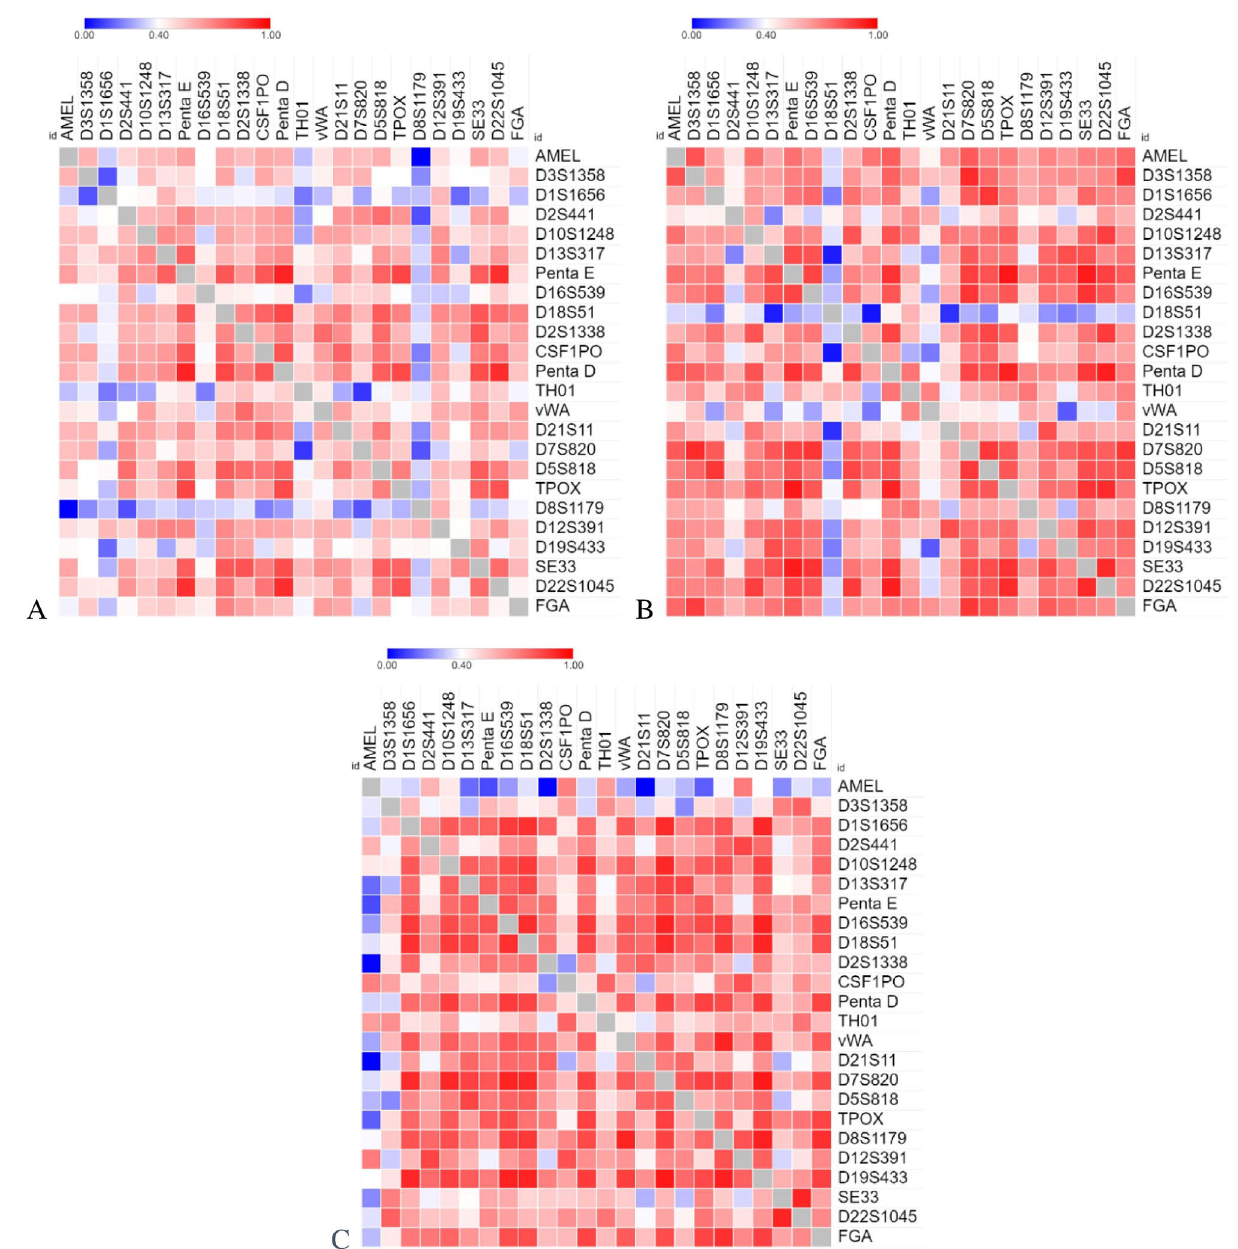
Figure 5. Spearman correlation of total allelic product at 29 cycles ( a ), 30 cycles ( b ), and 31 cycles ( c ) where the value of the correlation coefficients are: very high (0.9–1.0), high (0.7–0.89), moderate (0.4–0.69), low (0.1–0.39), and negligible